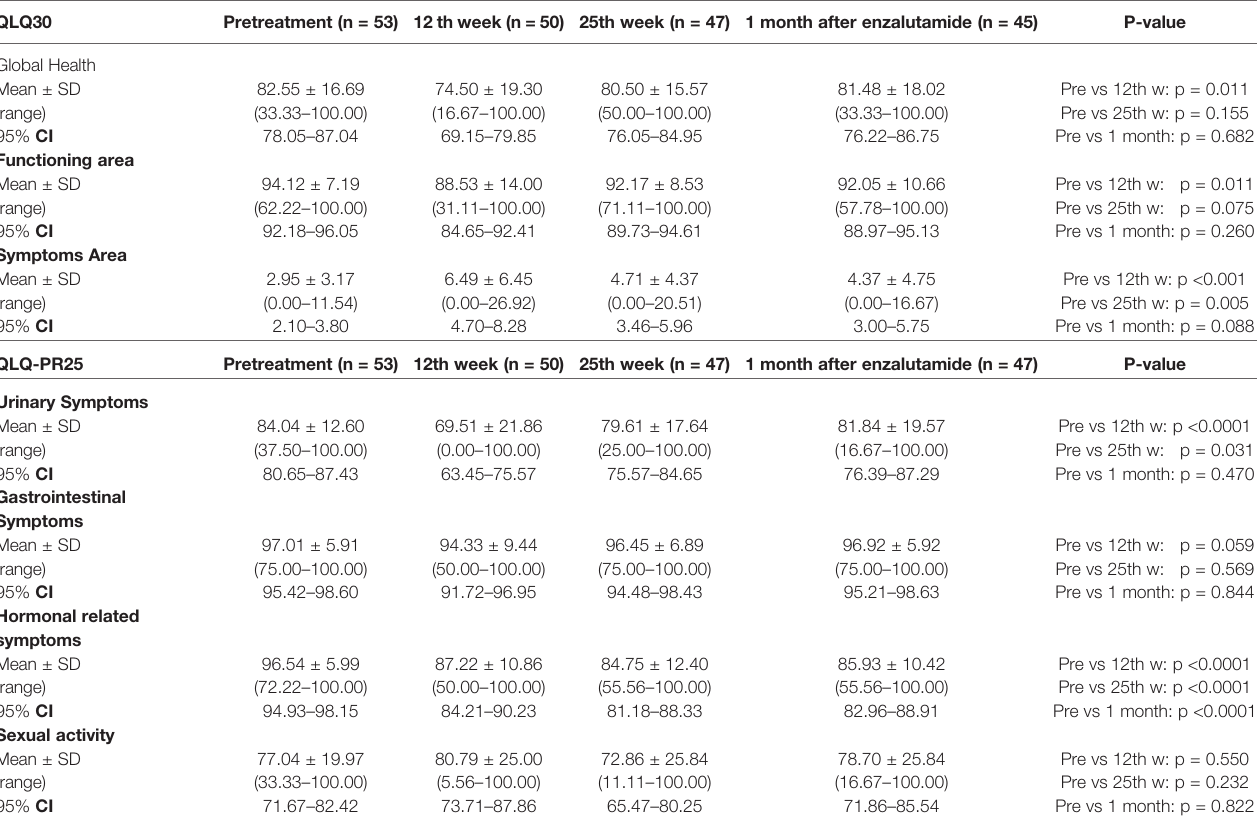
TABLE 6 | Quality of Life assessment at pre-speci fi ed time